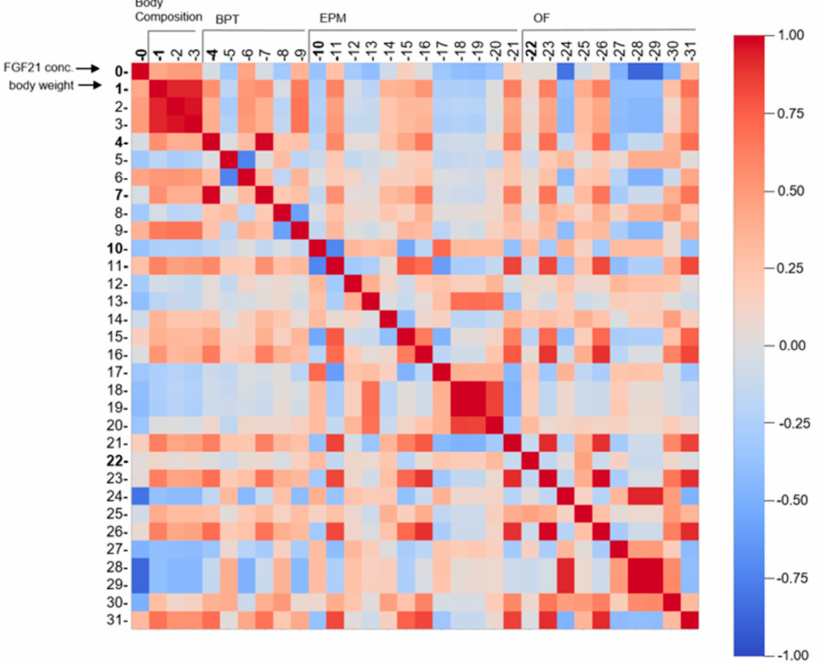
Figure 8. Pearson’s correlation represented as a multidimensional heatmap. Pearson’s correlation plot visualises the correlation values between all 32 acquired parameters. Scale bar represents the range of the correlation coefficients displayed. Red colour (1.00–0.70) indicates a strong positive correlation, blue colour ( − 0.70– − 1.00) reveals a strong negative correlation, whereas light colour above 0.40 or under − 0.40 indicates moderate correlation. Grey colour with coefficient approximately 0 displays no correlation. Numbers correspond to experiments as followed: 0 = FGF21 concentra- tion ( n = 82); 1–3 = Values of body composition ( n = 80–81); 4–9 = Observations of BPT ( n = 81); 10–21 = Observations of EPM ( n = 76); 22–31 = Observations of OF ( n = 53; see Table S1 for more information). All exact correlation values are displayed in Table S3. Abbreviations: FGF21: Fibroblast Growth factor 21, BPT: buried pellet test, EPM: elevated plus maze, OF: open